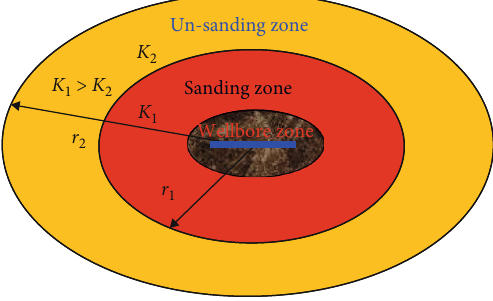
Figure 1: Physical model of composite